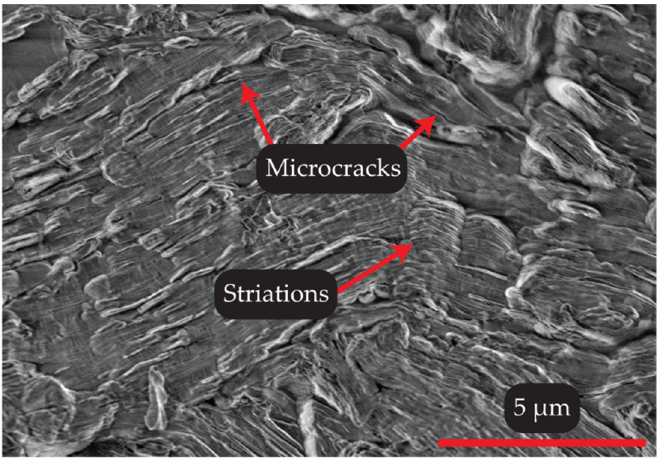
Figure 7. SEM image of grade M26 BN-SiO 2 after exposure to plasma. Comparison with Figure 4 demonstrates the change in surface microstructure caused by sputtering.